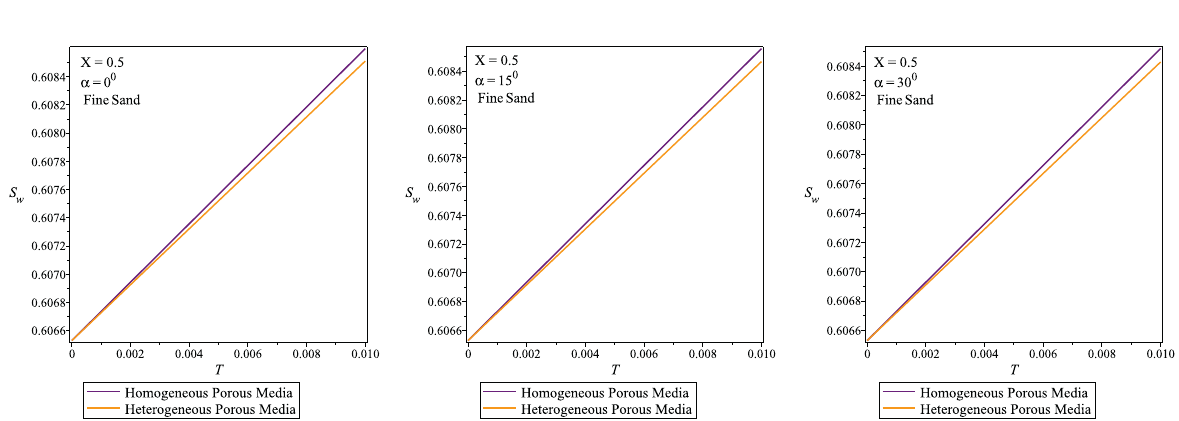
Fig. 5: comparison of saturation vs. dimensionless times for homogeneous and heterogeneous porous media in Fine Sand for different inclined plane α = 0 ◦ , 15 ◦ , 30